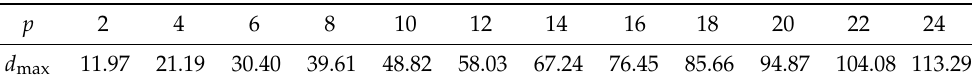
Table 1. The maximum distance ( d max ) as a function of the bit precision ( p